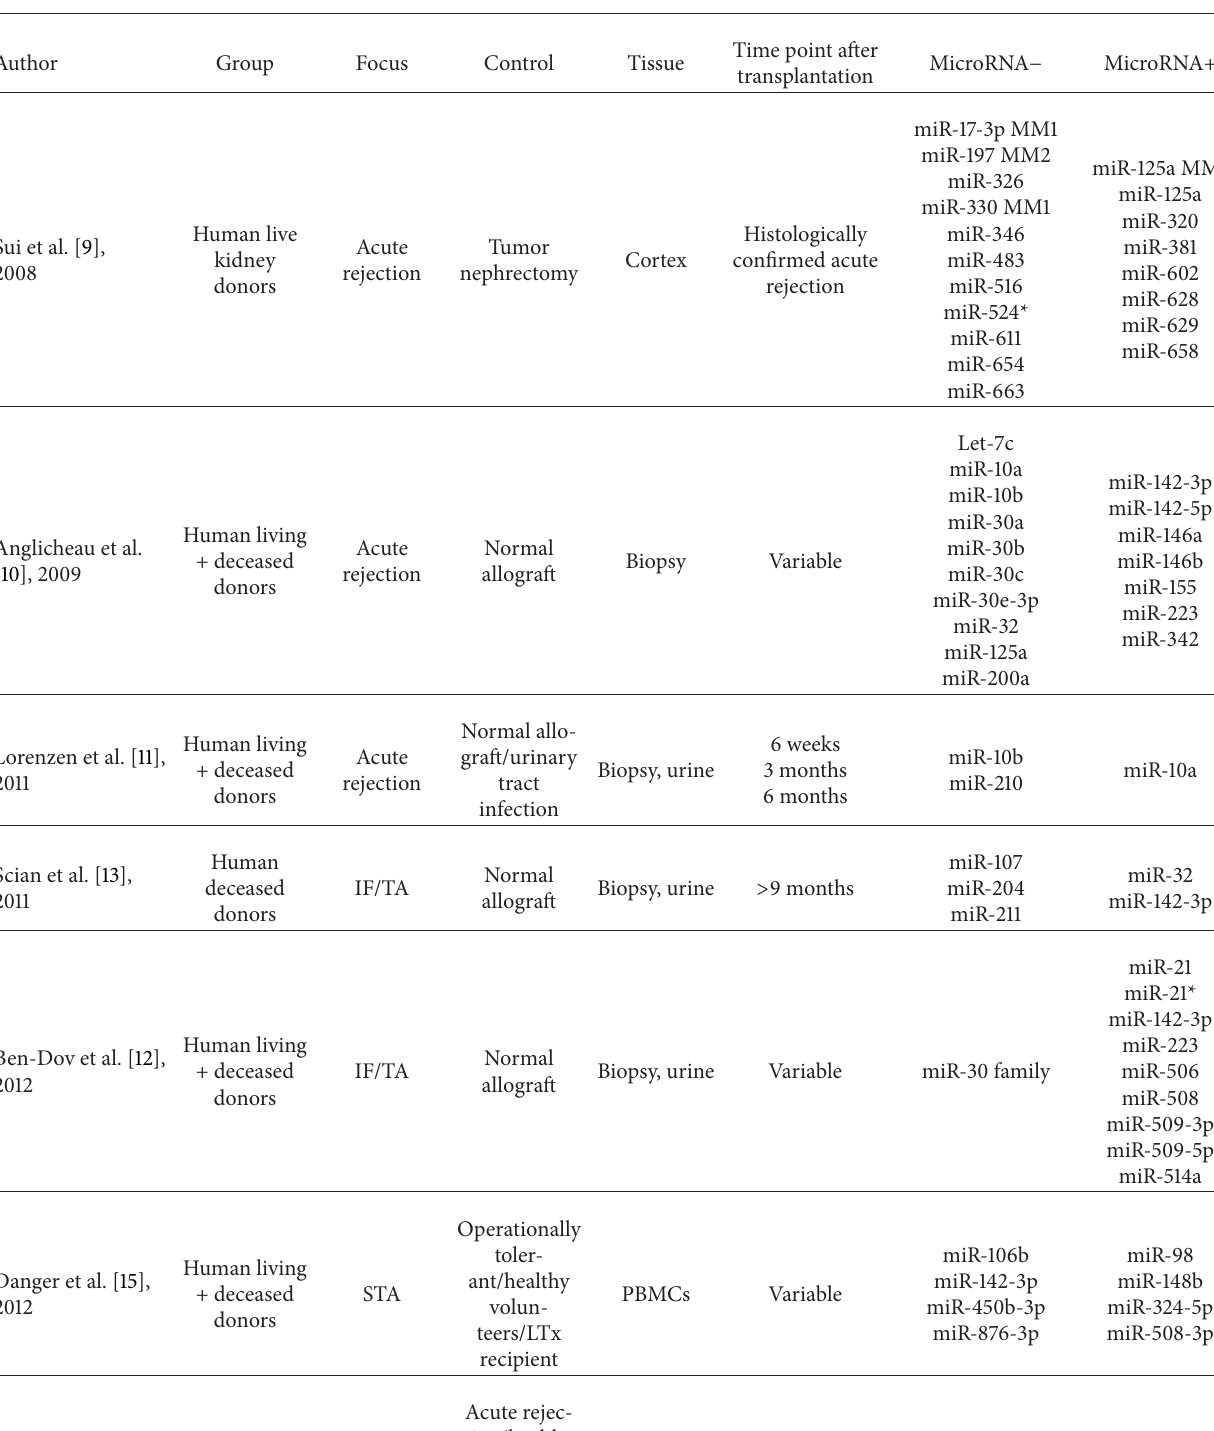
Table 2: Overview of experiments using human (kidney) tissue. LTx = liver transplantation. IF/TA = interstitial fibrosis and tubular